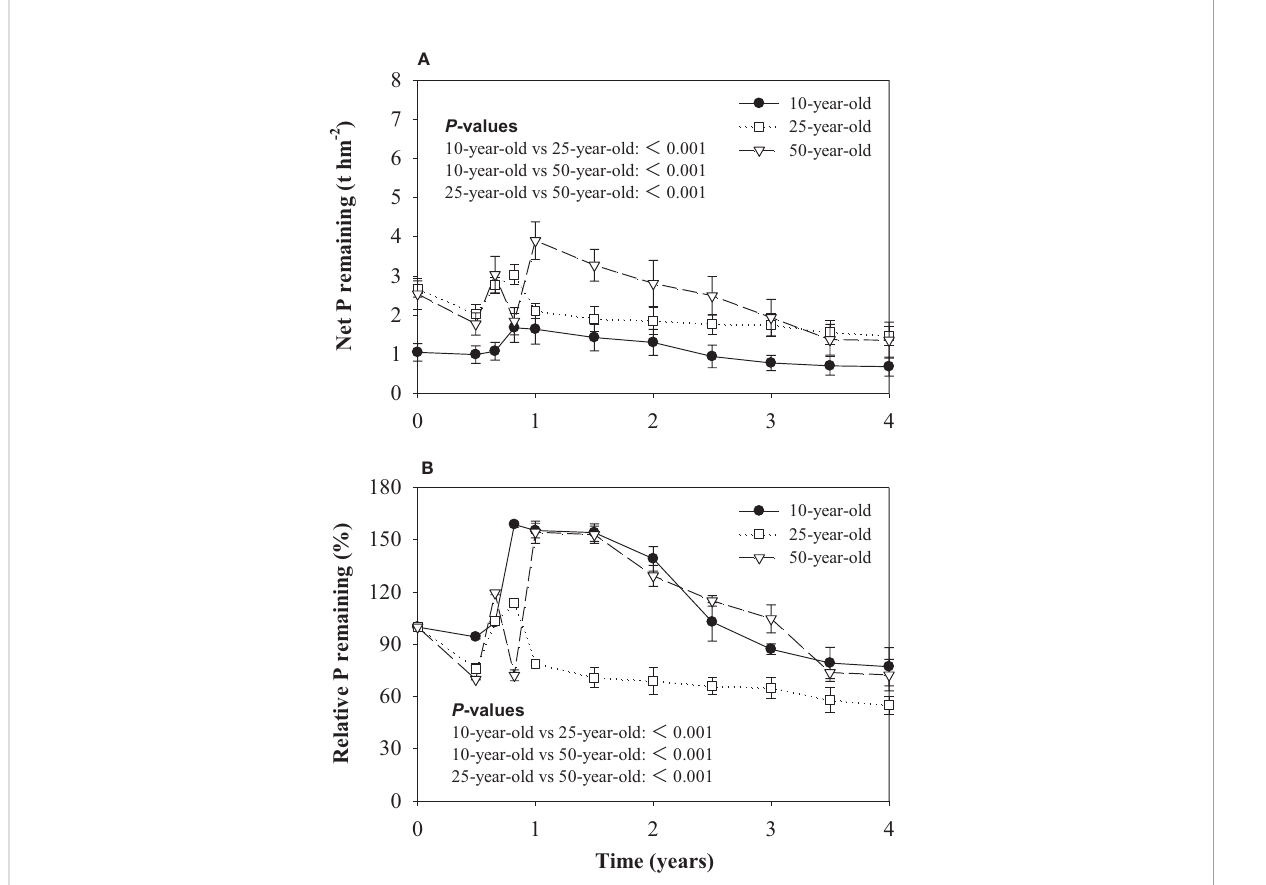
FIGURE 2 Litter net phosphorus (P) remaining (A) and relative phosphorus (P) remaining (B) over the decomposition period in experiment 1. P -values for effects of stand ages are obtained by linear mixed